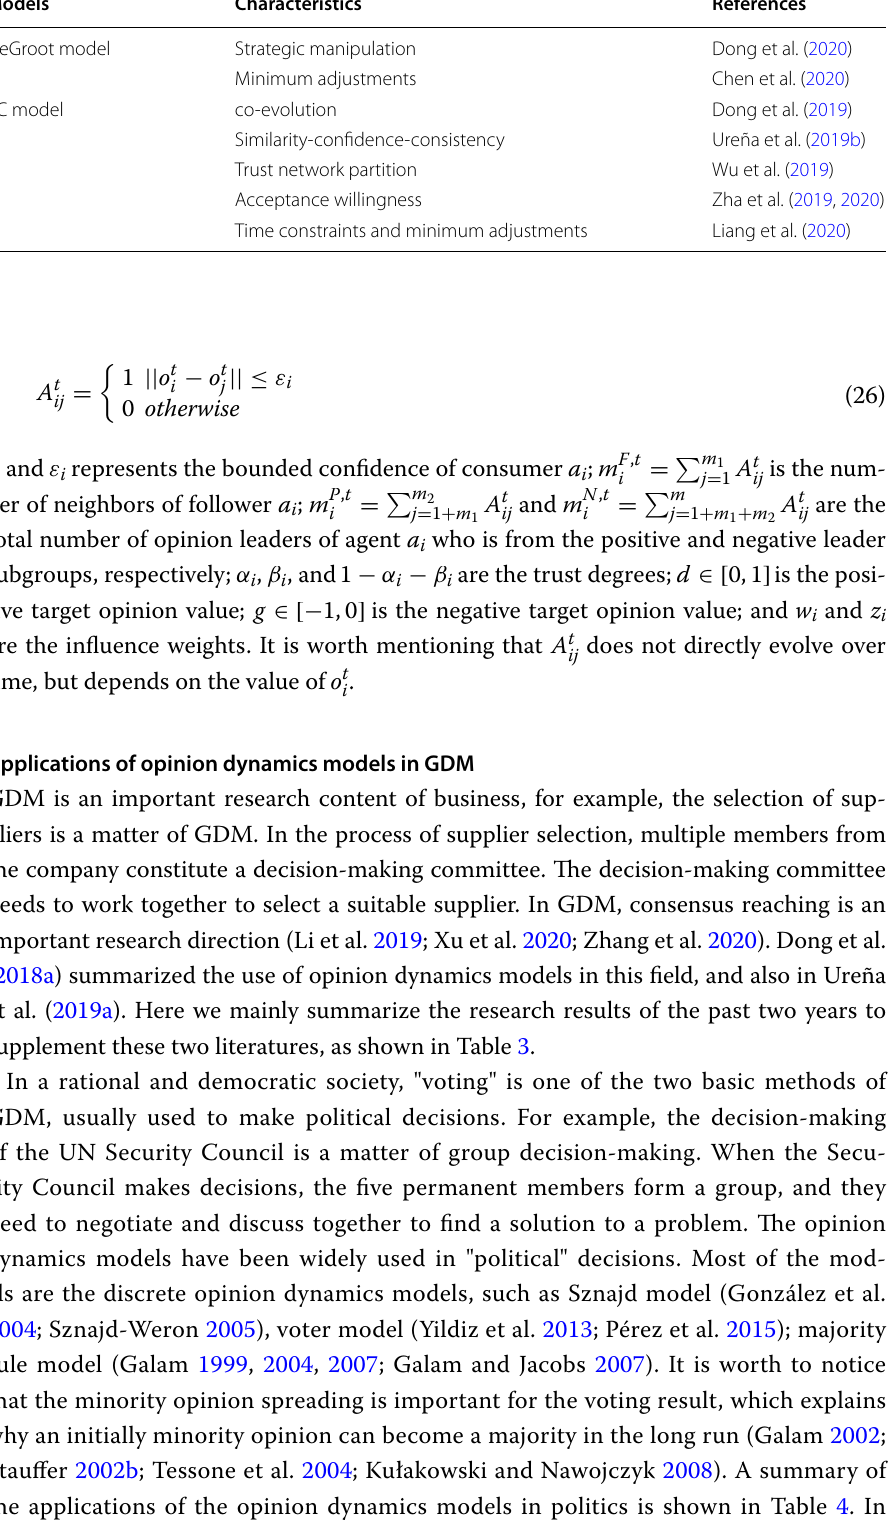
Table 3 The application of opinion dynamics models in GDM